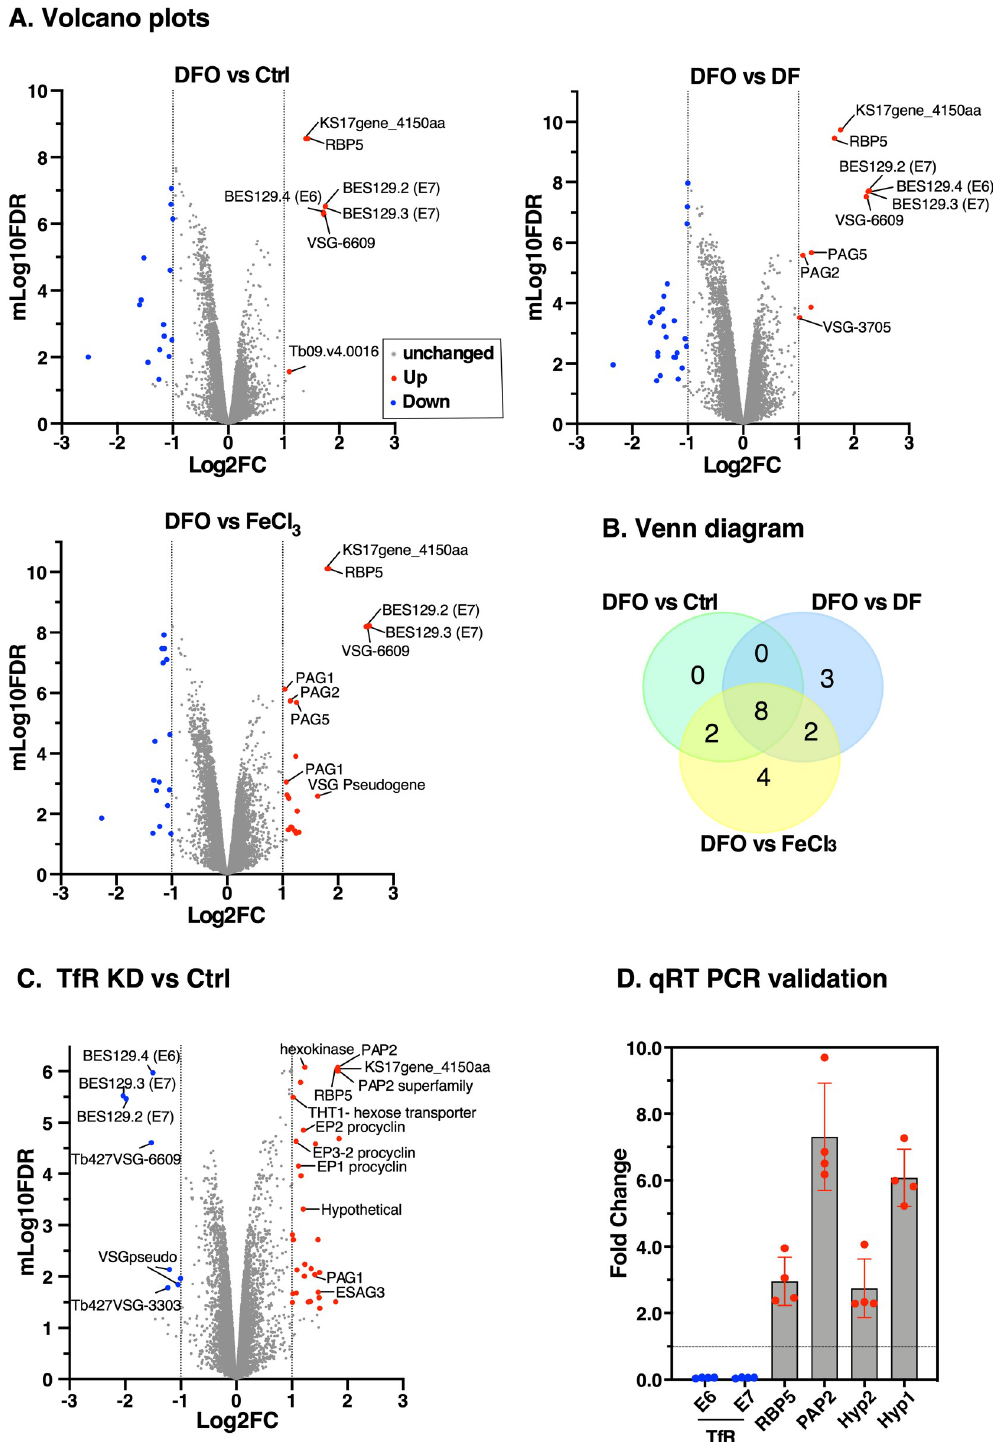
Fig 3. Transcriptional profiling of iron regulated genes in BSF T . brucei . A . Effect of DFO on the transcriptome. Log phase cells (~5x10 5 cells/ml) were incubated with 25 μ M DFO, 25 μ M DFO pre-saturated with 27.5 μ M FeCl 3 (DF), 25 μ M FeCl 3 or untreated (Ctrl). Total RNA was purified from three technical replicates for each condition and subjected to RNA sequencing. Volcano plots show transcriptome data of differentially expressed genes with 2-fold change relative to controls (FDR adjusted p-value < 0.05): grey dots (no change), red dots (upregulated), blue dots (downregulated). All differentially